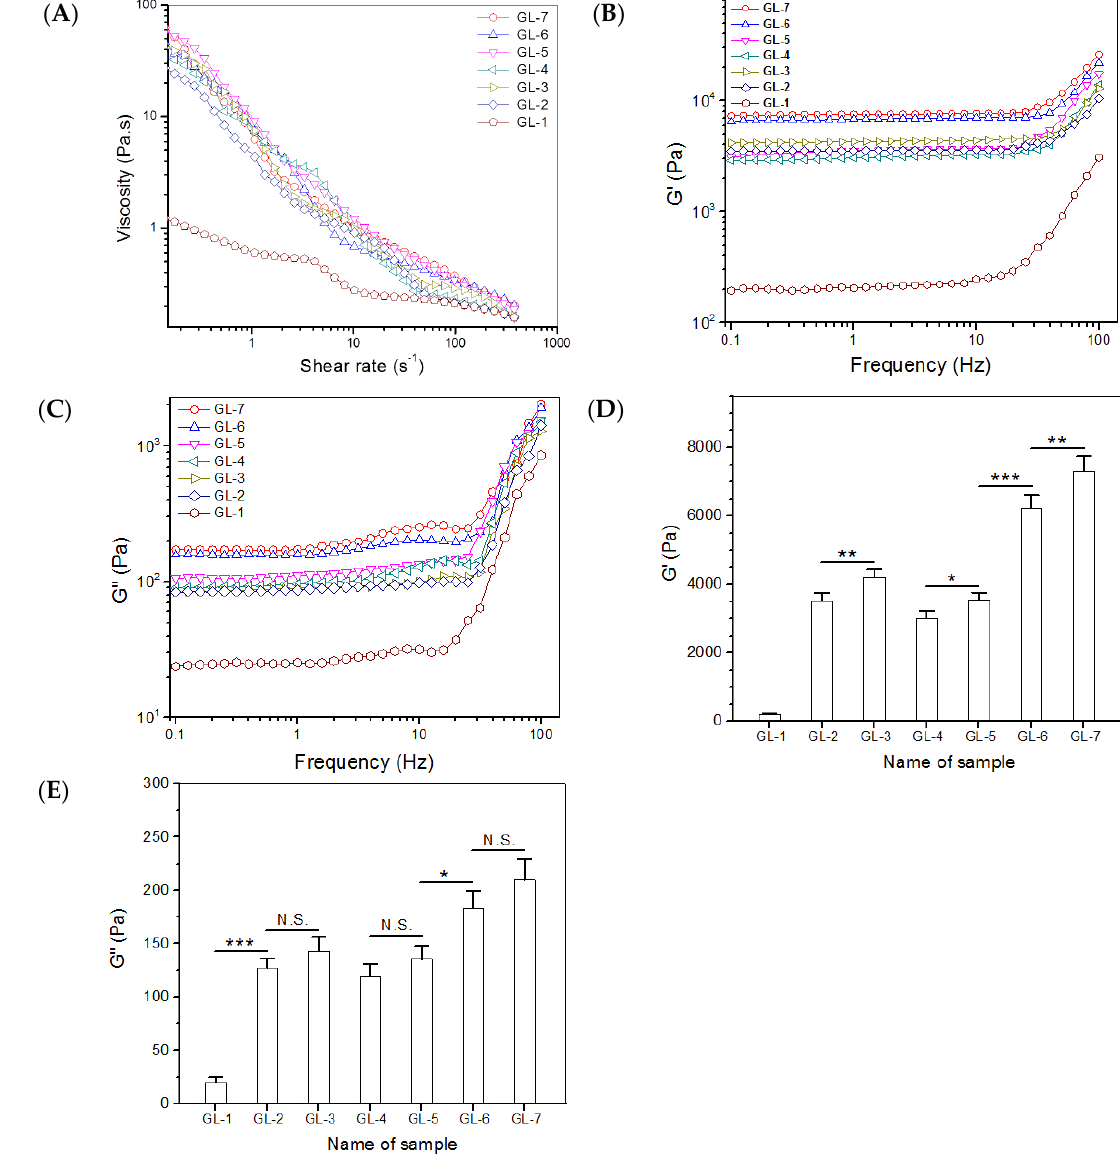
Figure 3. Shear-rate dependent variations of viscosity (( A ), 25 °C), frequency-dependent changes of G ′ (( B ), 37 °C) and G ′′ (( C ), 37 °C), and average value of G ′ (( D ), 37 °C) and G ′′ (( E ), 37 °C) at 1 Hz for different gels (***, p < 0.001; **, p < 0.01; *, p < 0.05; N.S., not significant).